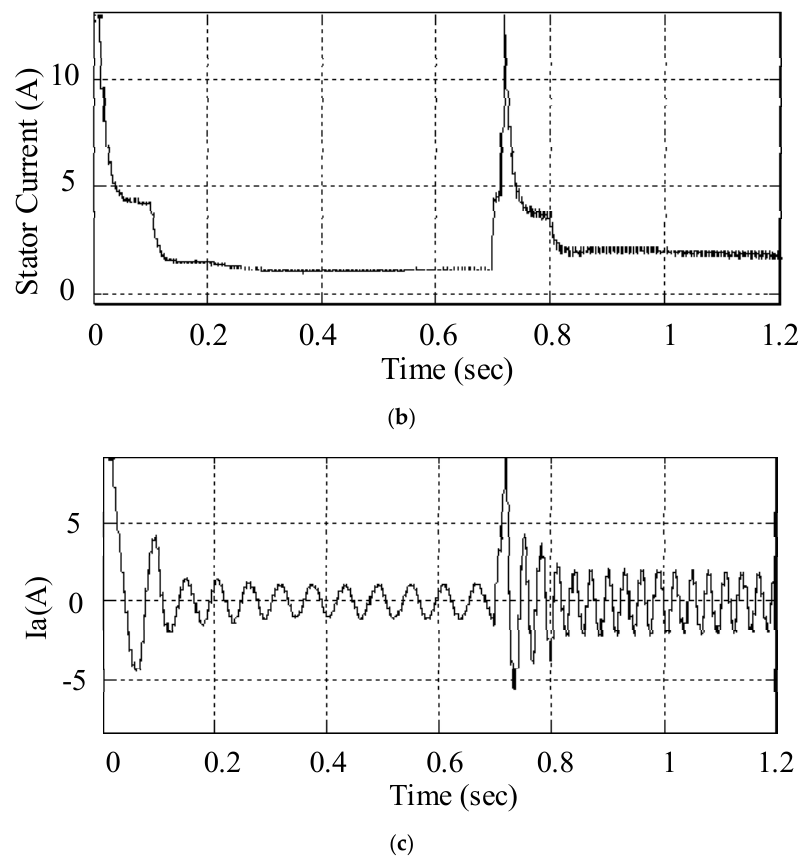
Figure 14. Results of optimal control under the MPTA strategy. ( a ) Magnetic flux, ( b ) Stator current size, ( c ) Stator phase current.